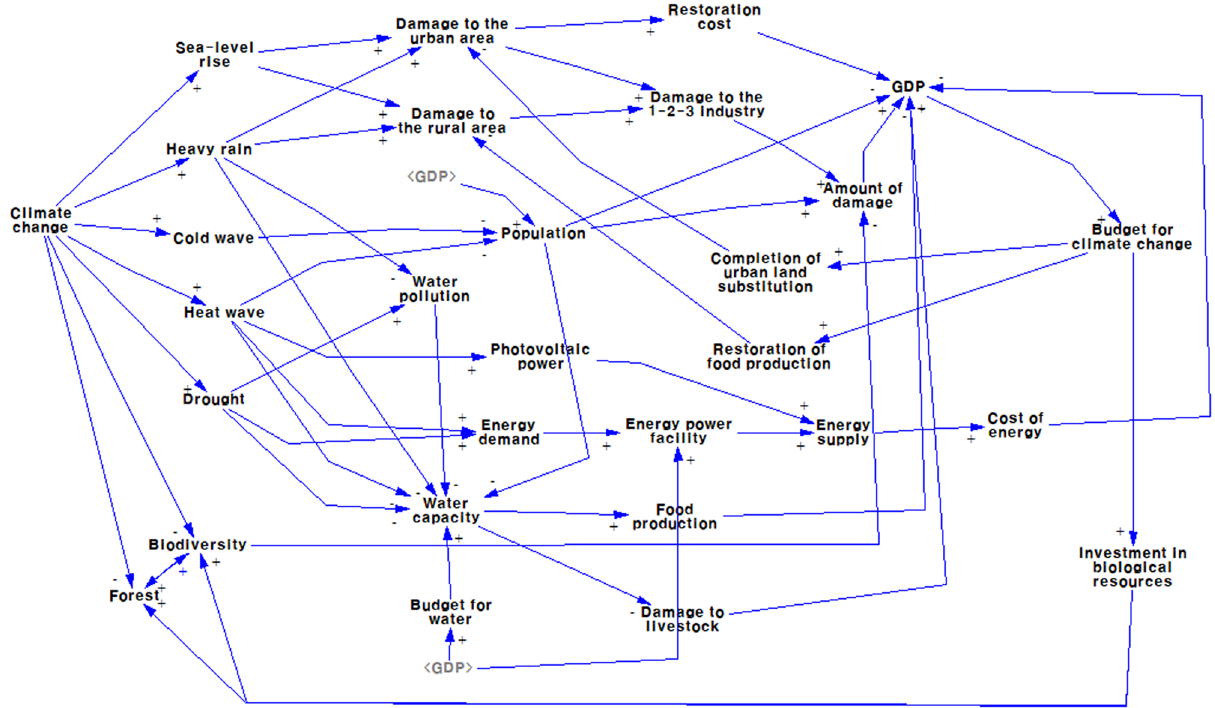
Figure 3. Causal-loop diagram of the climate change impact model. “1–2-3 industries” refers to the primary, secondary, and tertiary